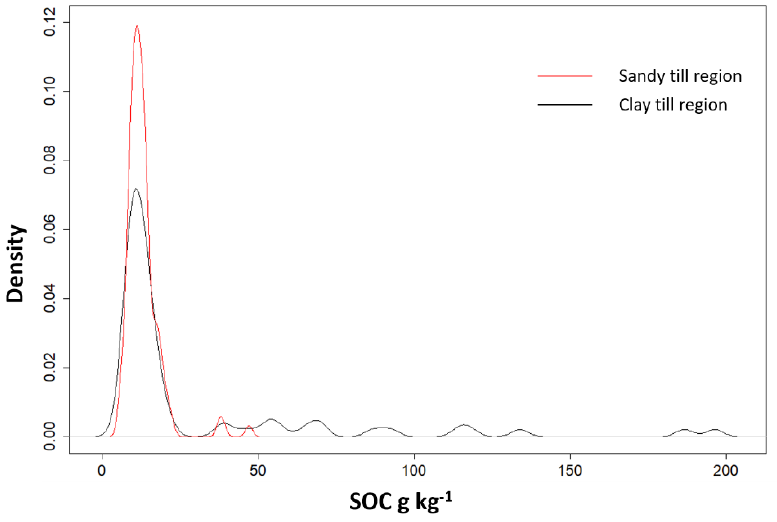
Figure 2. Kernel density estimate plot for the measured Soil Organic Carbon (SOC) values of theMecklenburg-West Pomerania (MWP) dataset.